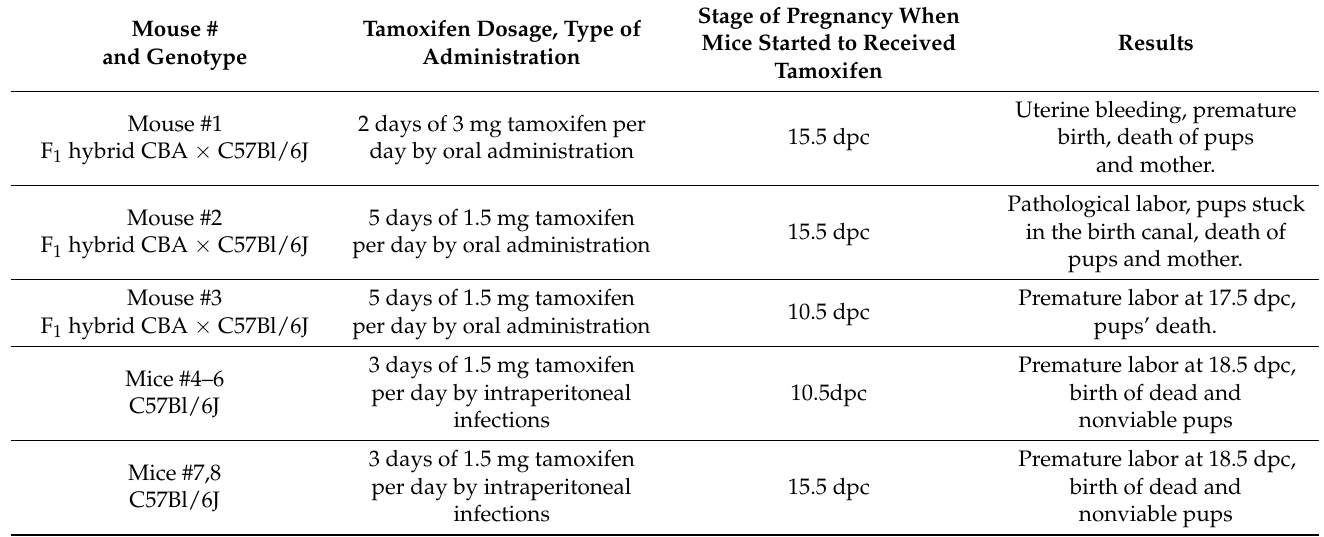
Table 2. Effects of tamoxifen action on pregnancy and embryonic development in